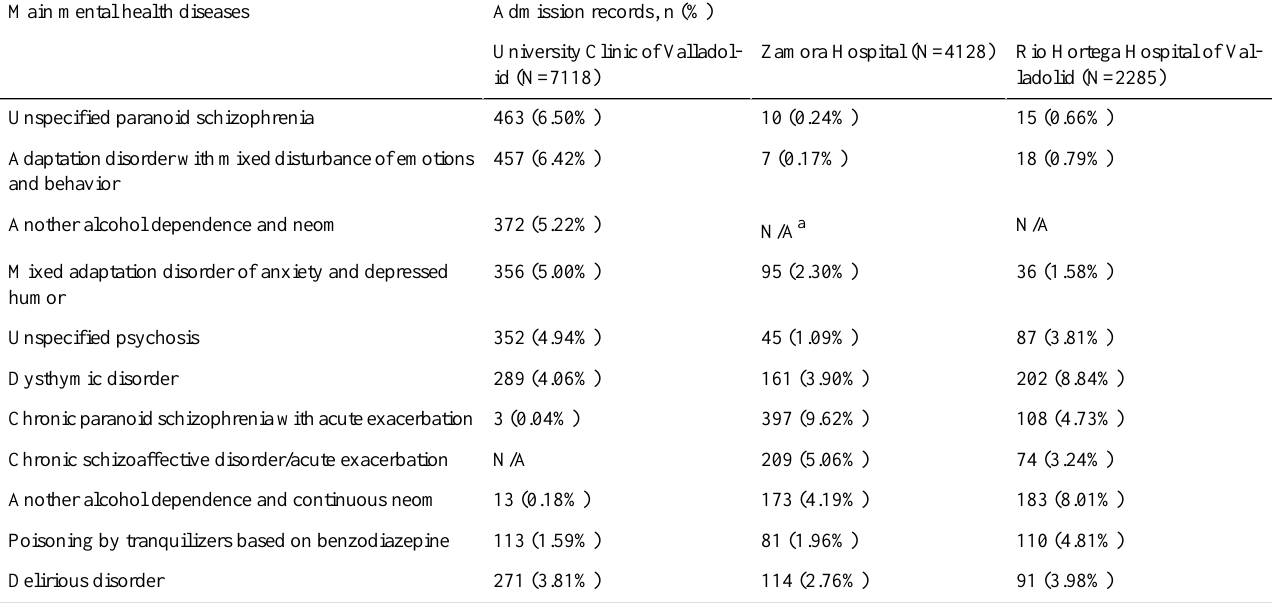
Table 1. Admission records according to mental health diseases for health care complexes in Valladolid and